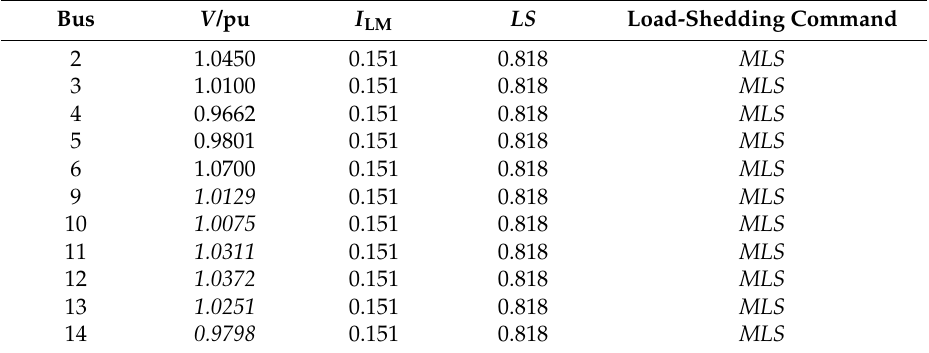
Table 6. The fuzzy outputs of all the fuzzy load-shedding controllers of IEEE 14-bus system with PV including an LTC